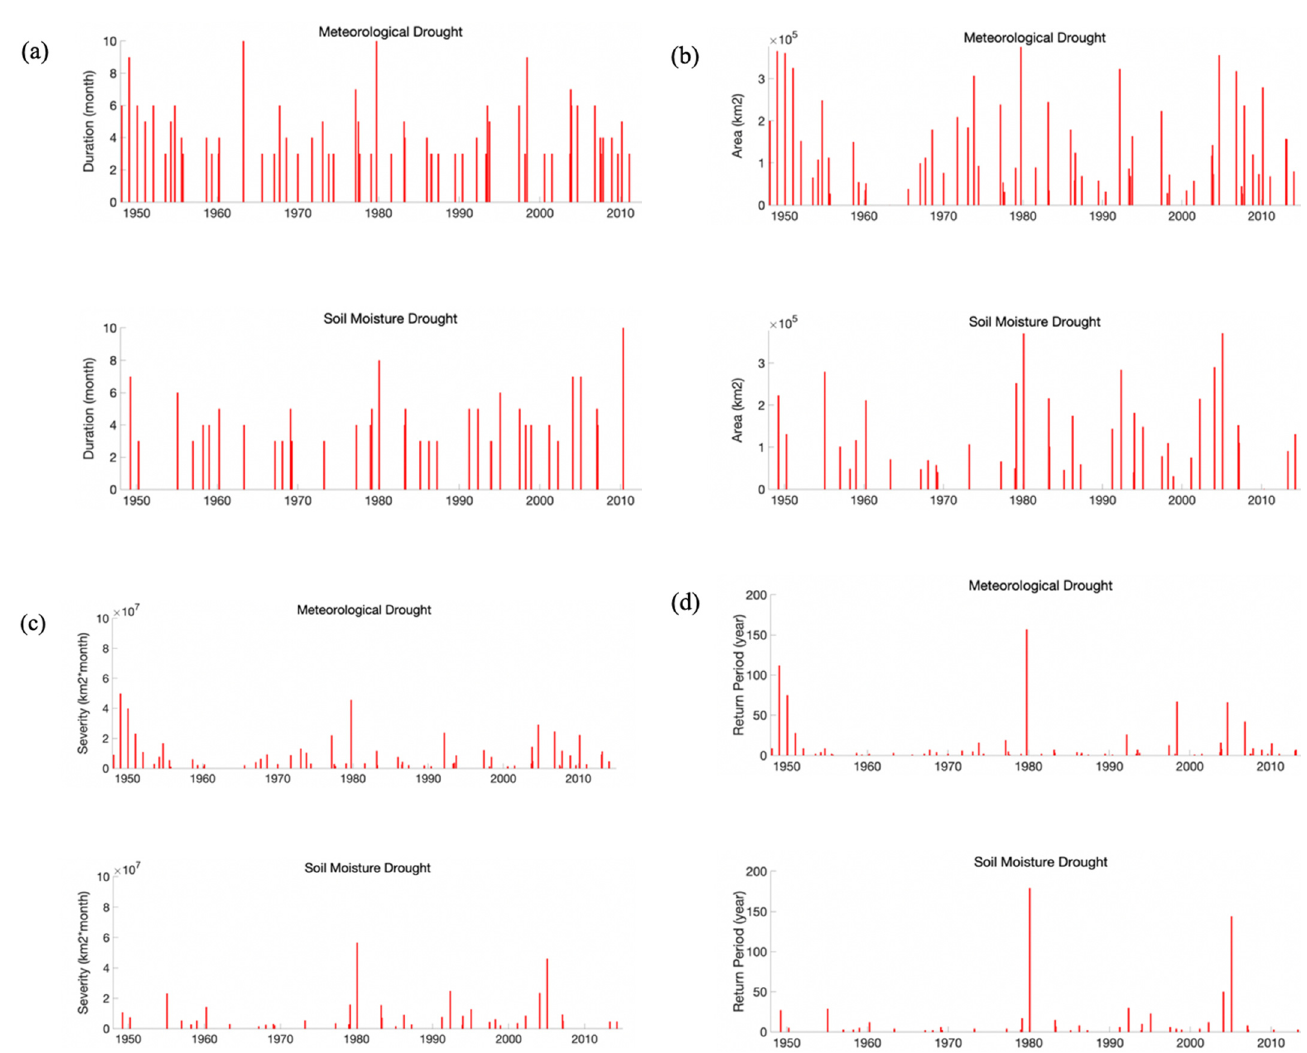
Figure 5. The temporal distribution of historical droughts in the past 67 years. ( a ) shows the drought duration of historical droughts; ( b ) shows the drought area of historical droughts; ( c ) shows the drought severity of historical droughts; ( d ) shows the trivariate return period of historical droughts.